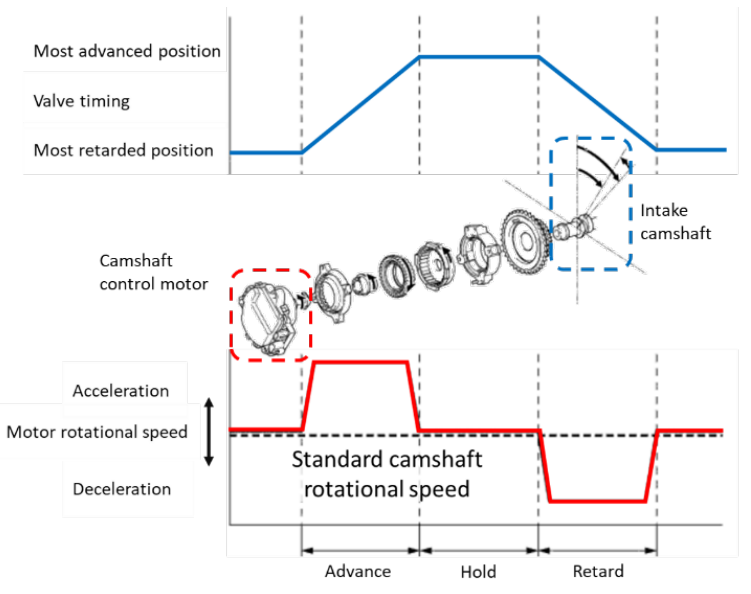
Fig. 5. Relationship between electric motor speed and advance and retard timing [34]